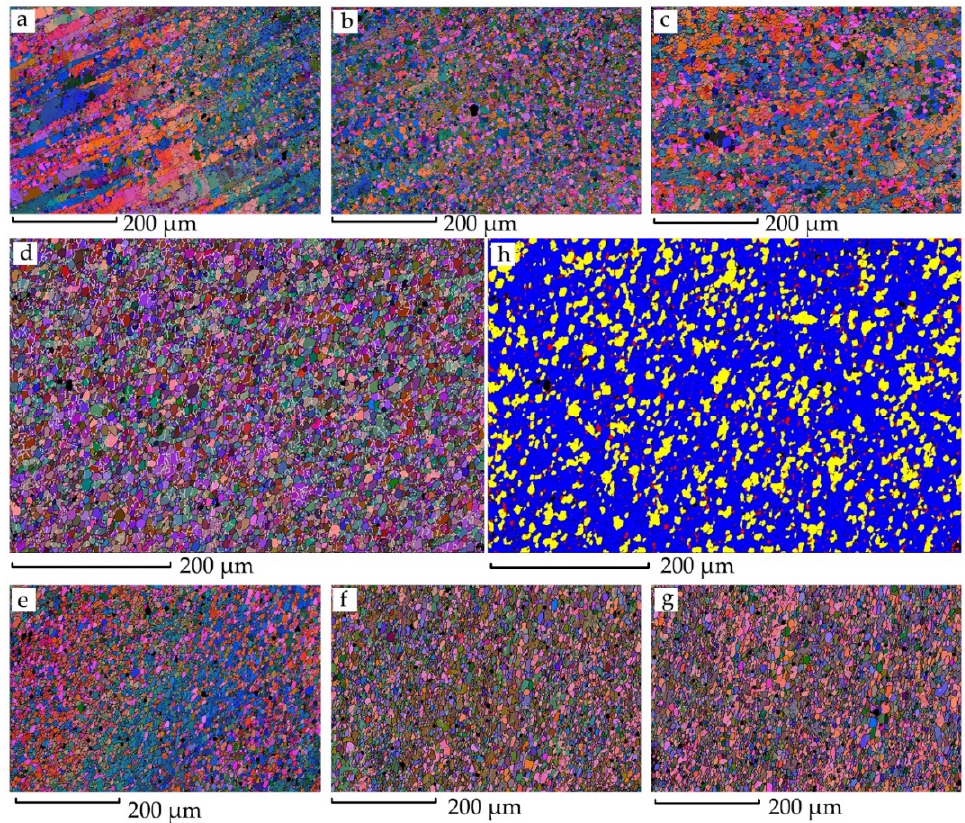
Figure 4. EBSD results of the joint. Image ( a – g ) correspond to the rectangle regions in Figure 3. Image ( h ) is the recrystallized fraction result of the region ( d ).